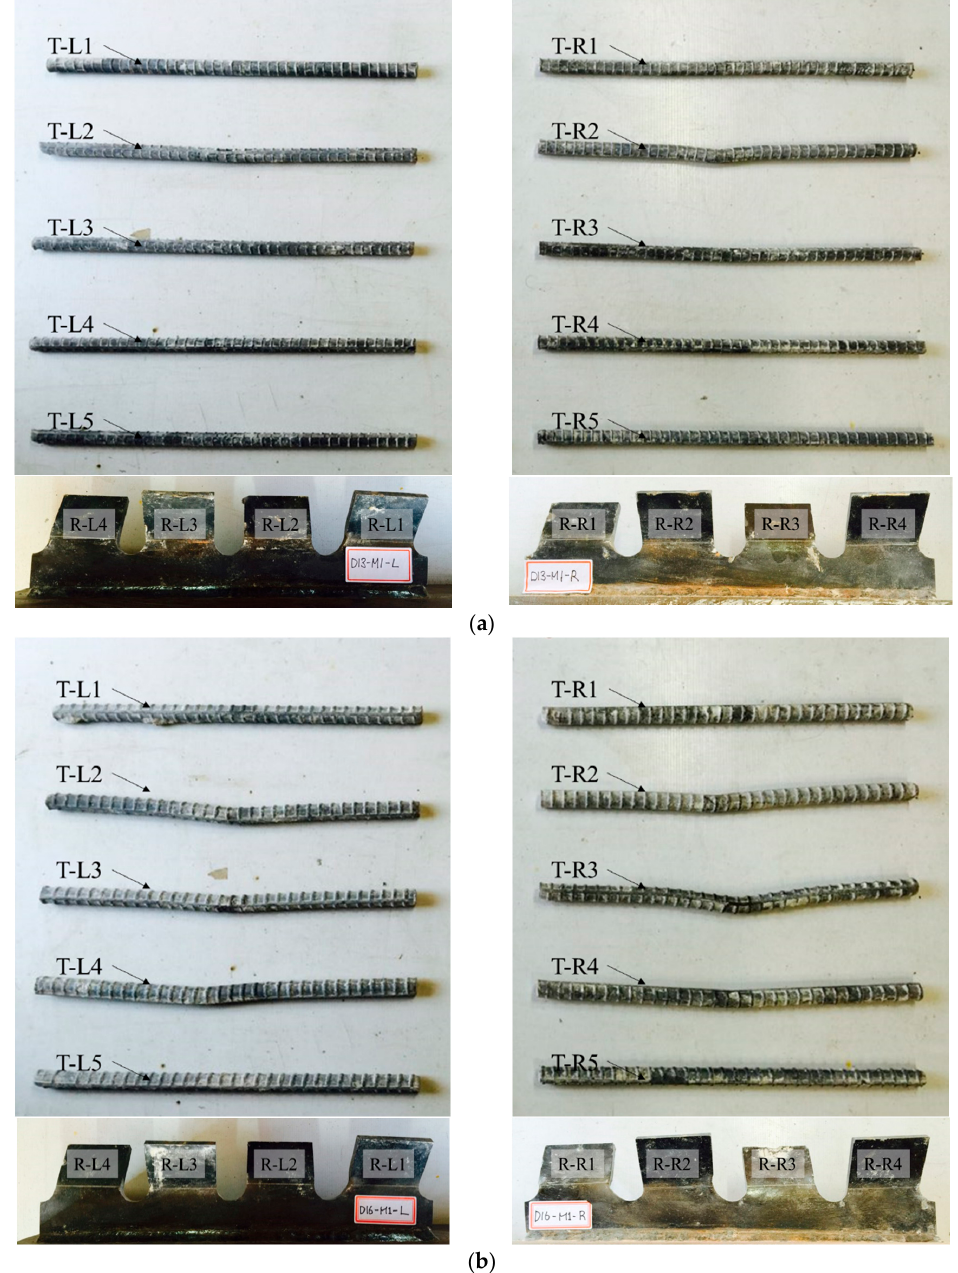
Figure 10. Deformation of transverse rebars and ribs; Stage 3: ( a ) SY-D13-M1; ( b ) SY-D16-M1.